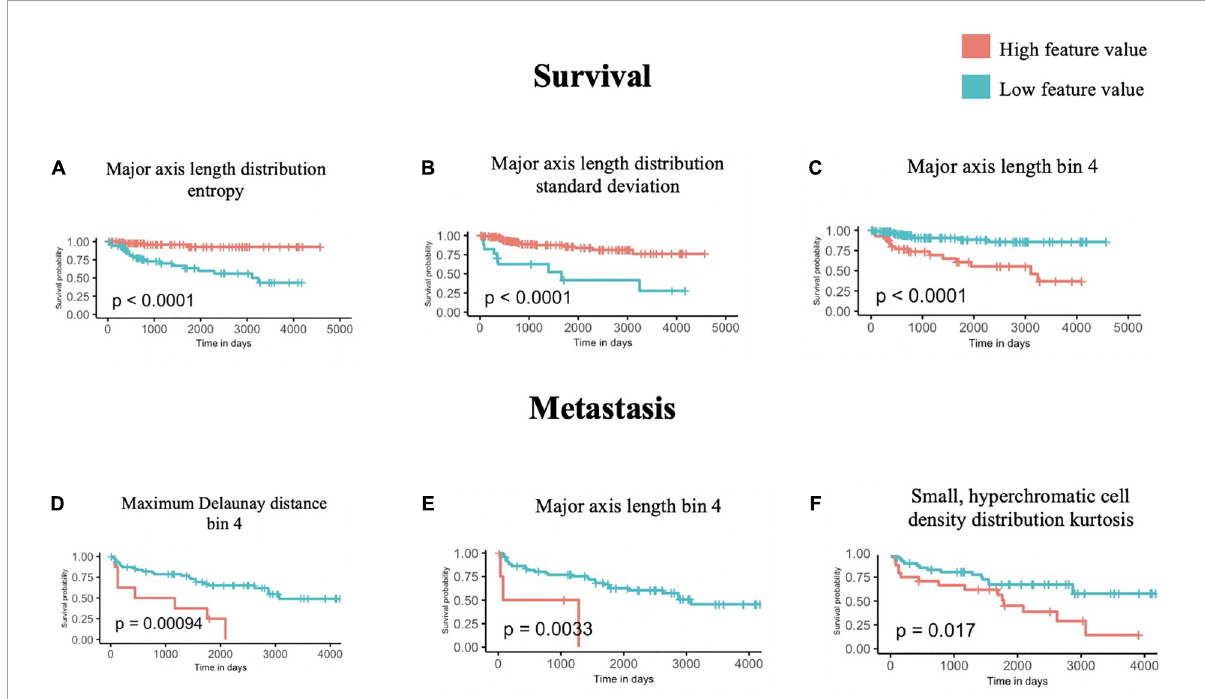
FIGURE3 Univariate survival and metastasis analysis. After scanning through 100 cutoffs through the range in values for each feature, the cutoff providing the most significant p -values from log-rank tests of survival (A–C) and metastasis (D–F) times are used to generate Kaplan-Meier curves.